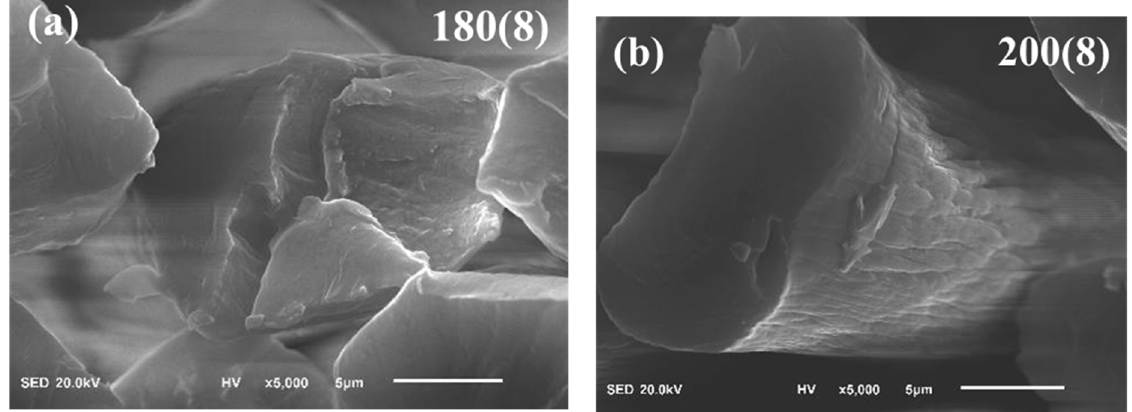
Figure 4. The cross-section view of the pre-oxidized specimen ( a ) 180(8) and ( b ) 200(8) using SEM. Figure 5 reveals the variance of XRD results for the pre-oxidized specimens. The raw PAN fiber figured two characteristic peaks, one was (100) at 2 θ = 17°, and the other was (110) at 2 θ = 29°. These peaks implied the chemical structure of the fiber was a chain- shaped texture, and they would gradually diminish during the annealing process. Then